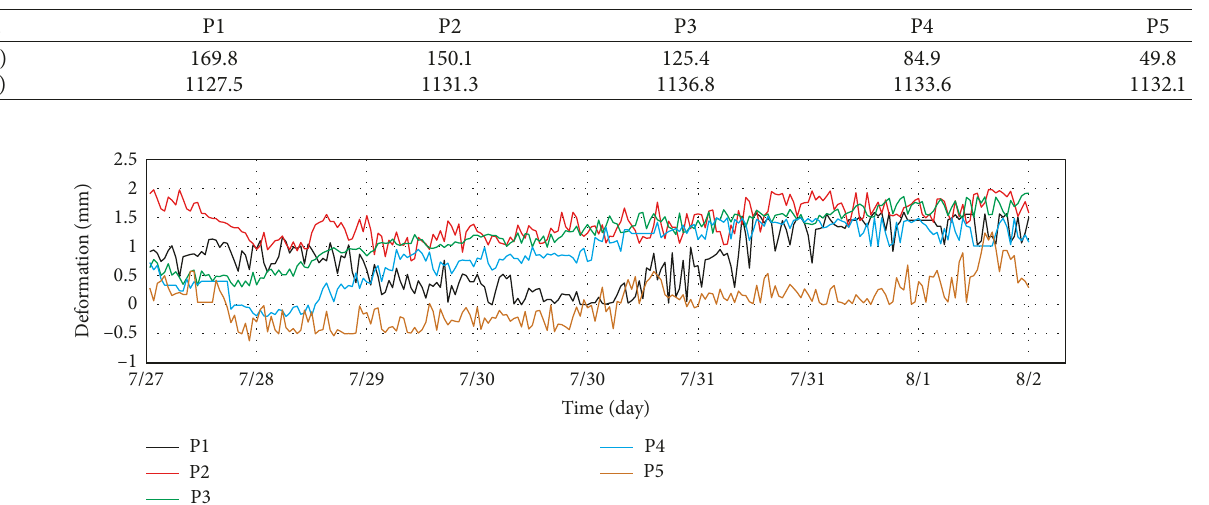
Figure 19: Temporal process curves of the five points at the top of the dam obtained using the PS